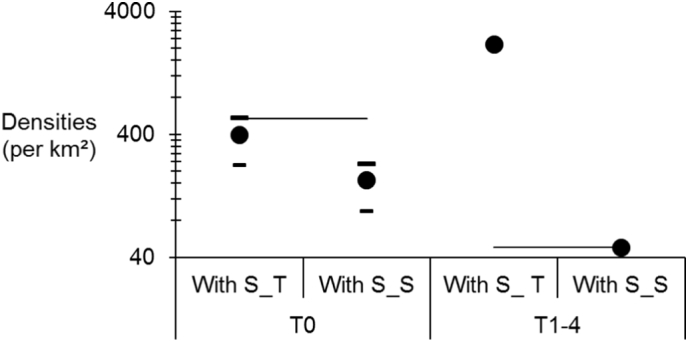
Population densities of Glossina palpalis palpalis with three methods: effective population density using the threshold distance for genetic subdivision (De_T), effective subpopulation size using the average sampling surface of a site (De_S) and census density (Dc) (thin straight line). Effective population densities are represented with their average minimal and maximal values. Estimates are given for subsamples before the control campaign (T0) and after control (T1–4). Ordinates were scaled in log.